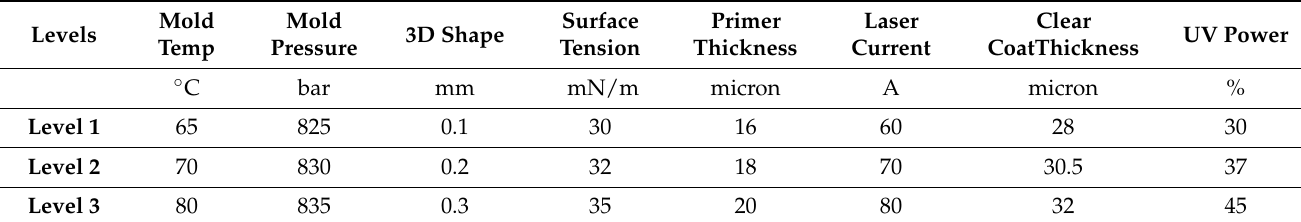
Table 1. Factors and their levels for Taguchi